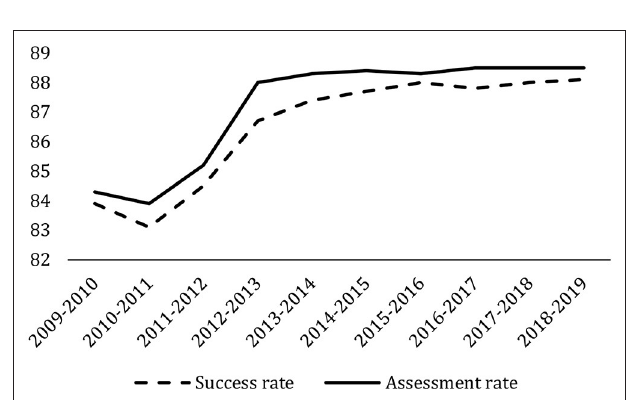
FIGURE 9 | University success and assessment rates in Spain. Percentages. Academic years 2009/2010–2018/2019. Integrated University Information System